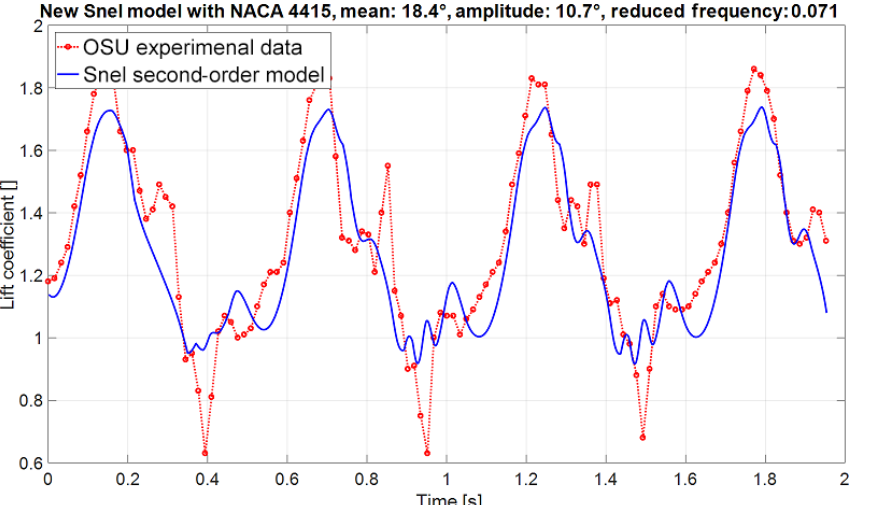
Figure 8. Lift coefficient over time of the improved Snel model (NACA 4415 aerofoil with mean angle of attack of 18.4 ◦ , amplitude of 10.7 ◦ , and reduced frequency of 0.071).